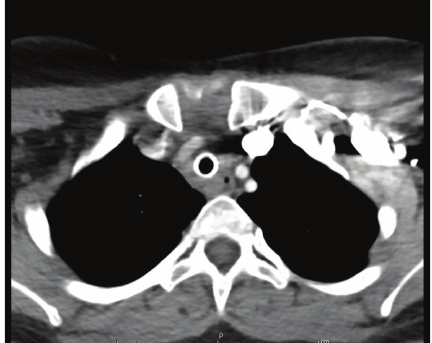
Figure 2: Innominate artery without fistulous tract.